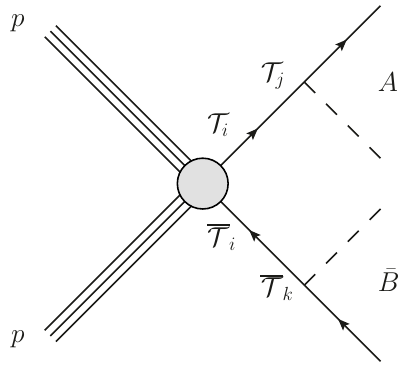
Figure 4 . Feynman diagram for the process pp → T T → A ¯ B where T denotes the lightest top-partners T and X , while A and B represent any of the decay channels shown in table 3. 2 / 3 2 / 3 The propagators are labeled with e.g. T i , T j to emphasize that the nearly degenerate top-partners can mix as shown in eq.